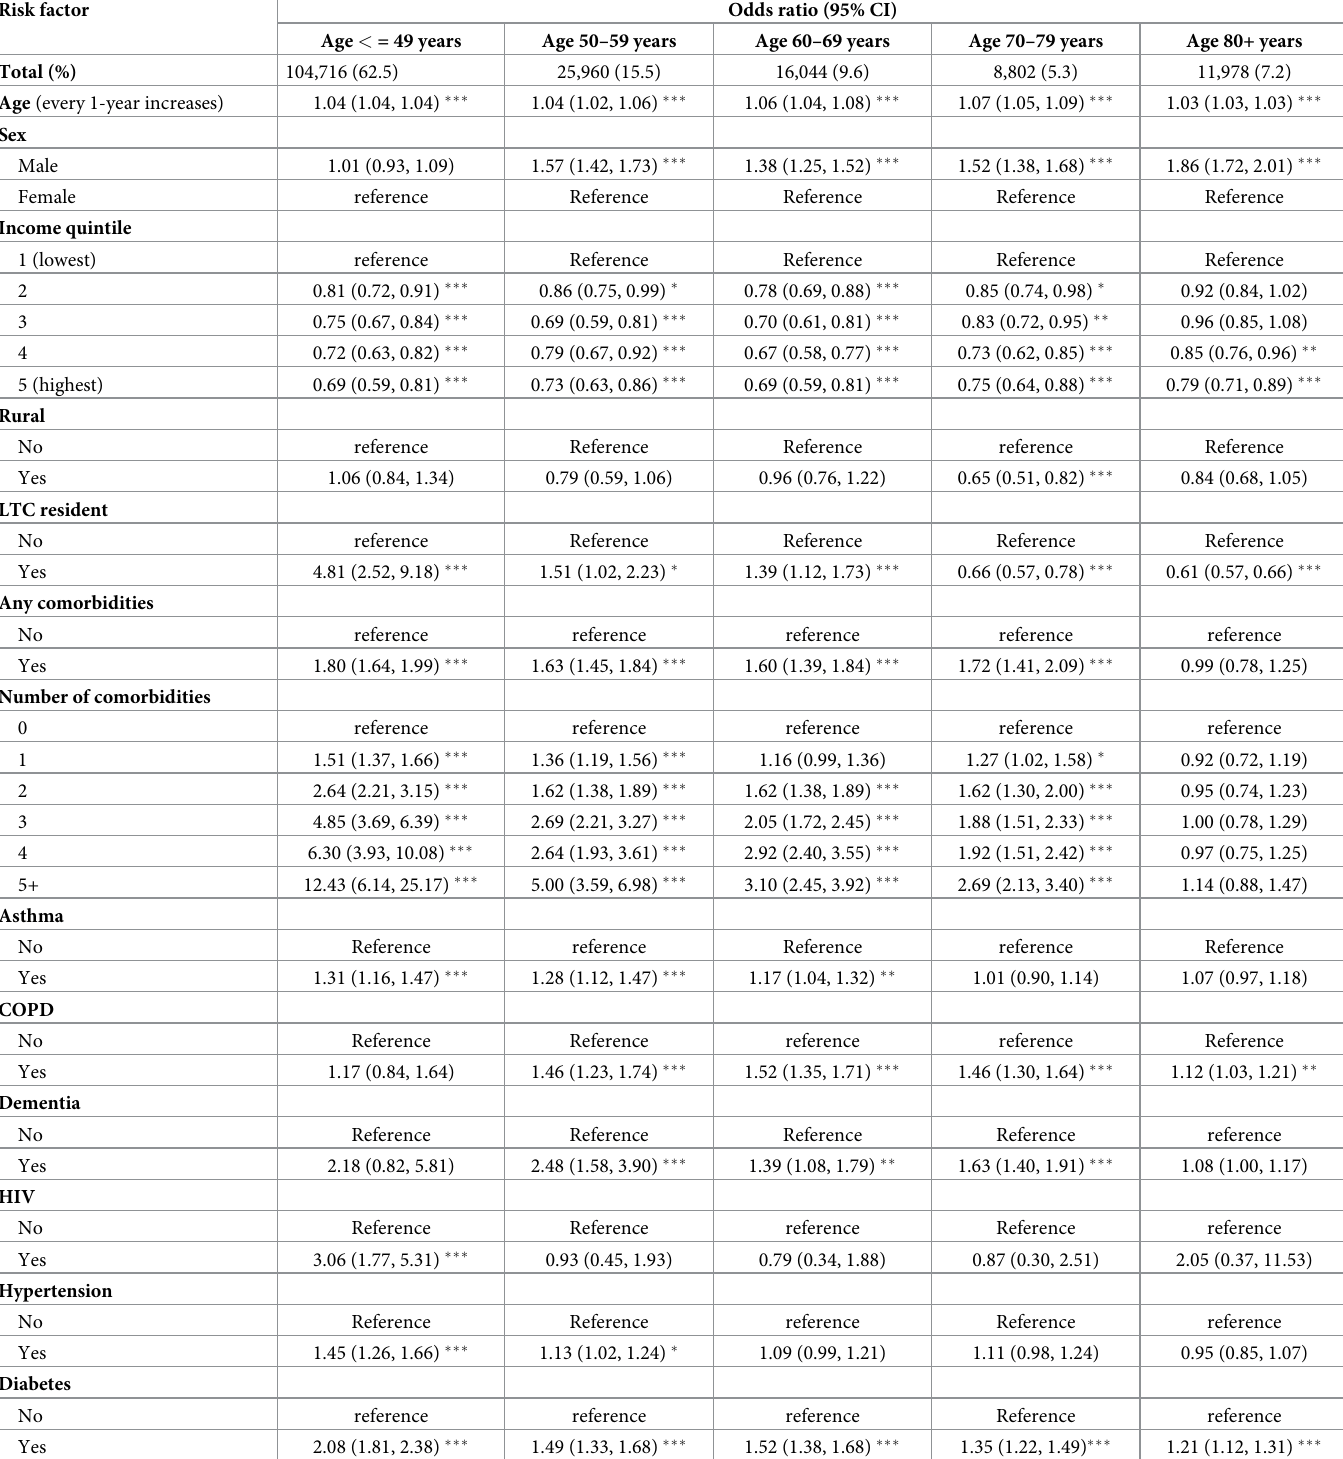
Table 3. Age groups based analyses regarding associations of demo-socio-economic characters and comorbidities with the composite severity outcome that includes all-cause 30-day mortality and hospitalization by logistic regression